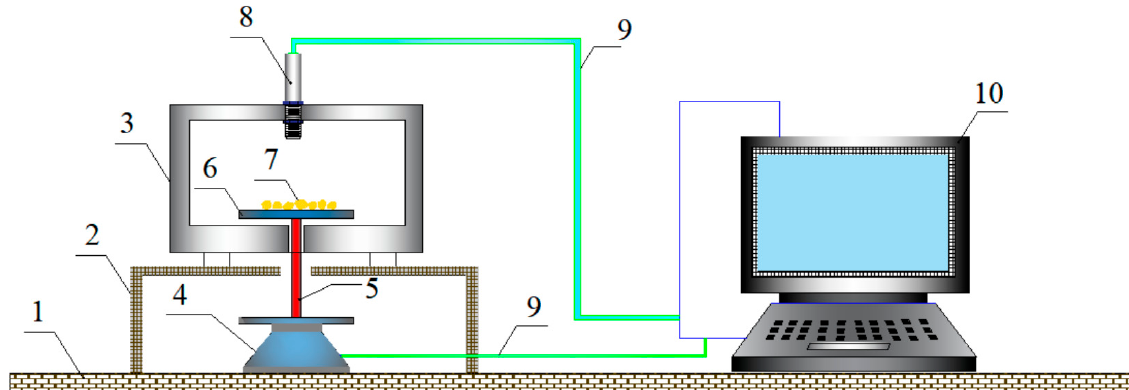
Figure 1. Microwave drying system of corn. 1 — Test bench; 2 — Bearing; 3 — Microwave oven; 4 — Electronic balance; 5 — Stents; 6 — Tray; 7 — Corn; 8 — Infrared thermometer; 9 — Cable; 10 — Computer.